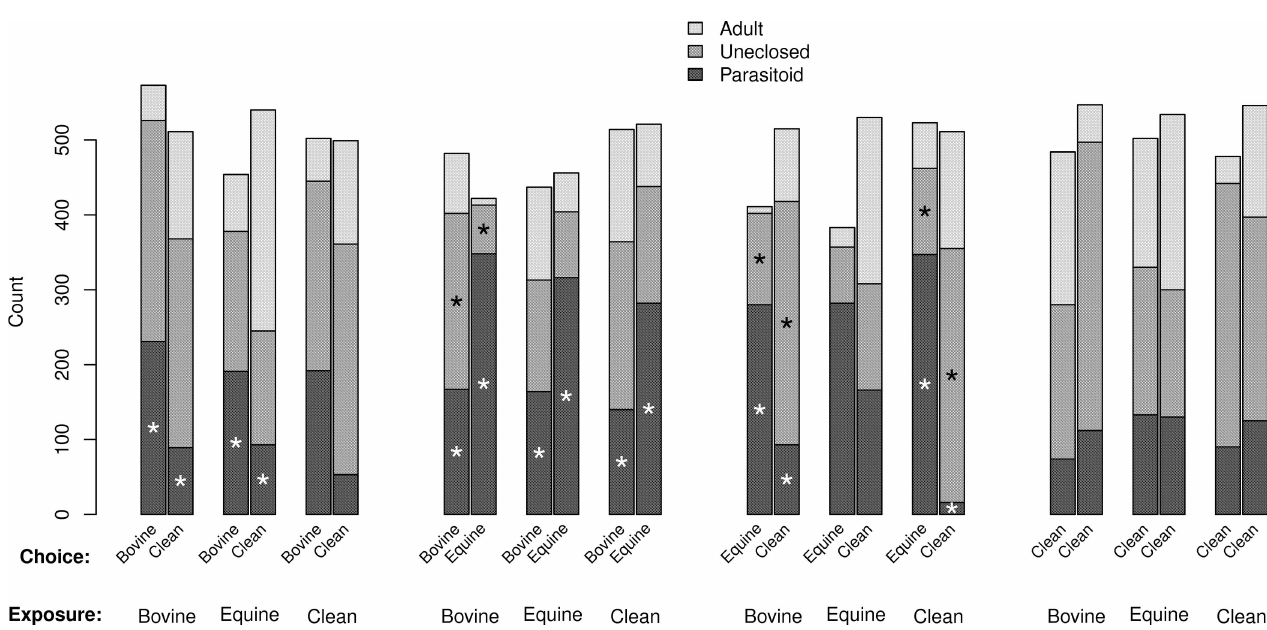
Fig 2. Frequencies of outcomes of house fly host pupa in paired choice tests for 125 female Spalangia cameroni parasitoids (five replications of 25). Paired bars give choices, with shadinggivingthe three possibleoutcomes (adult = adult fly emerges, uneclosed= nothing emerges, parasitoid= parasitoidemerges). Parasitoidswere exposedto one of three conditions prior to testing (bovine manure, equinemanure, no manure = clean). Asterisks in paired bars indicate significantdifferences in counts (choicetested as a 1-parametercontrast in a generalizedlinear model assuming an over-dispersed binomialdistribution).